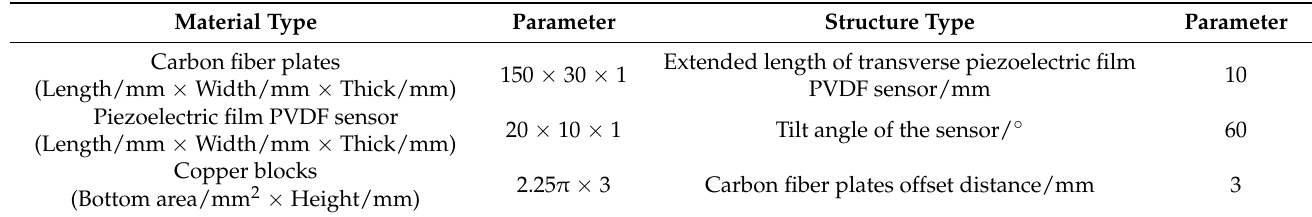
Figure 1. Schematic diagram of tactile sensor. ( a ) The physical diagram of tactile sensor; ( b ) diagram of experimental setup of tactile time-series acquisition. Table 1. Material and structural parameters of the tactile